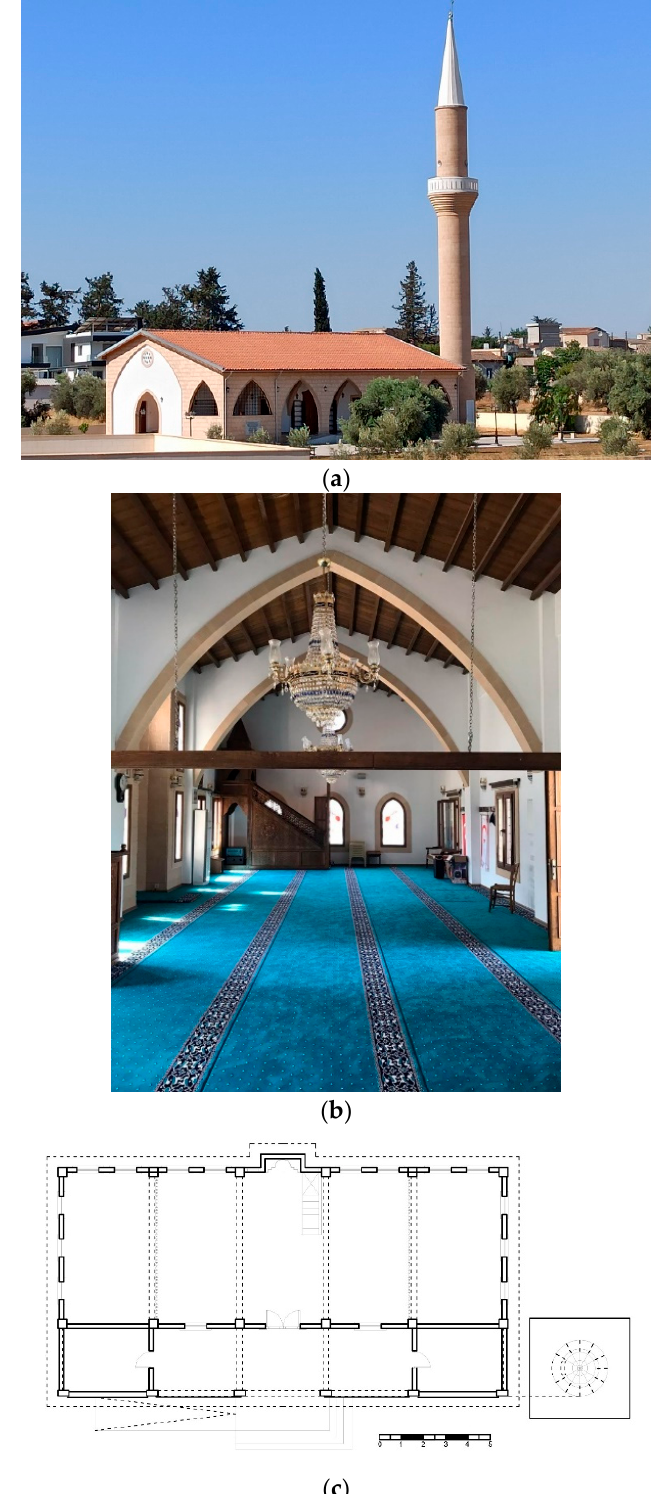
Figure 12. Akova/Gypsou, neo-vernacular mosque, type C, 2016/17: ( a ) entrance façade; and ( b ) interior (photo: authors). ( c ) Neo-vernacular mosque, type D, plan (drawing by authors and Mojtaba Karimnezhad, based on a plan from the Evkaf Construction Department).